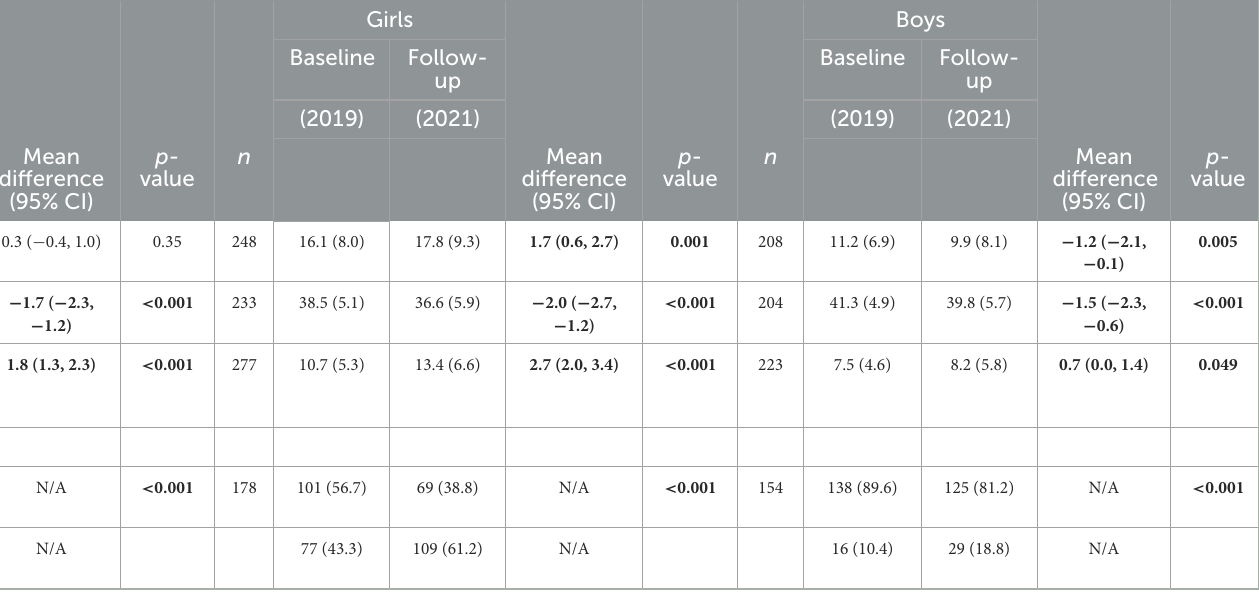
TABLE 2 Baseline and follow-up data for mental health outcomes, stratified by gender. All participants Girls Boys Baseline Follow- up